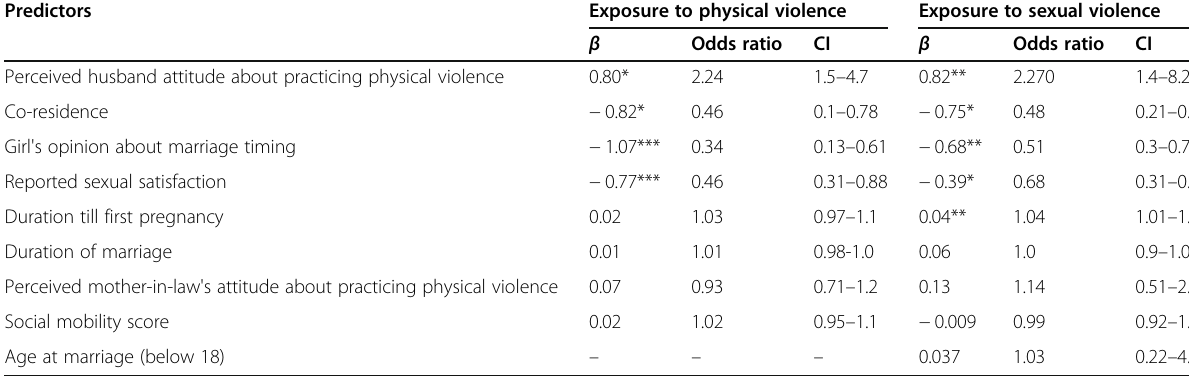
Table 4 Predictors of exposure of married adolescent girls (MAGs) to physical and sexual violence, Upper Egypt